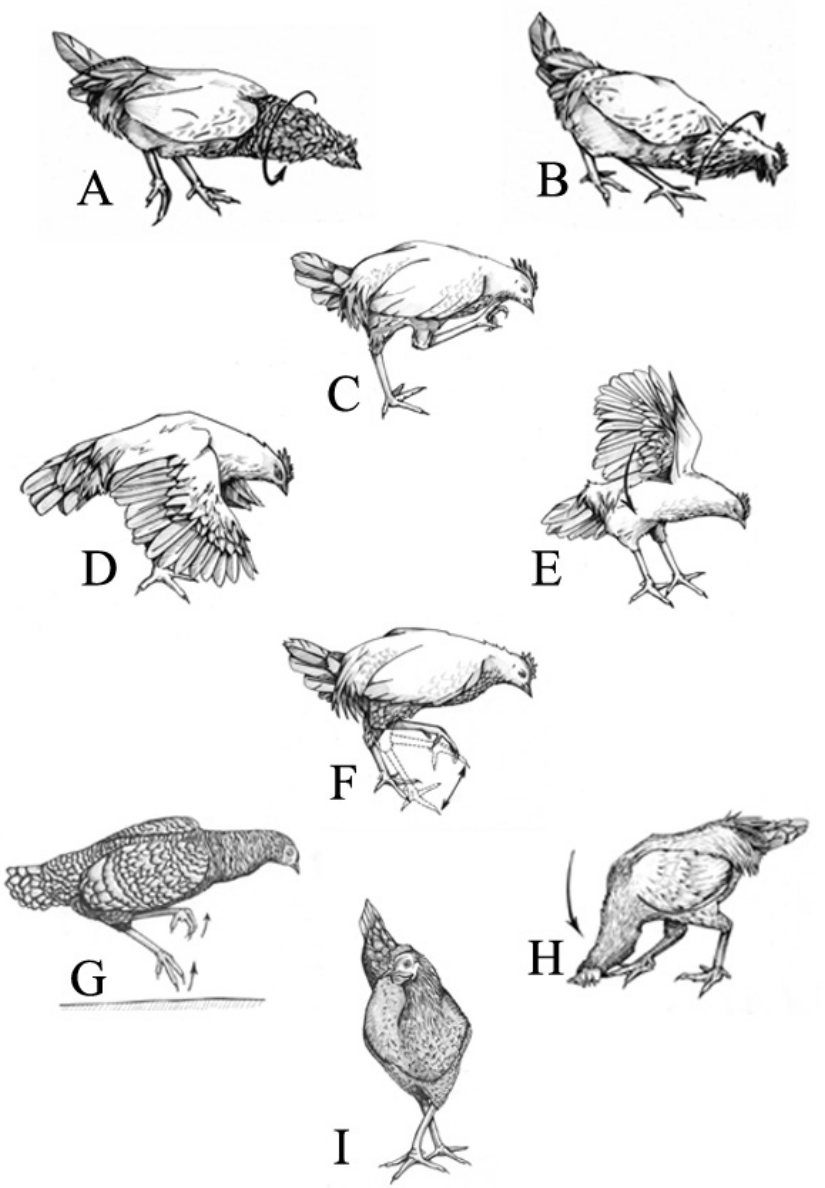
Figure 1. Representation of the aversive behaviors of the hen Gallus gallus domesticus when interacting with the yellow scorpion Tityus serrulatus . ( A , B ) shaking head; ( C ) scratch the beak/face with feet; ( D , E ) open wings; ( F ) stomp; ( G , I ) – jump; ( H ) – scratch the beak/face on substrate. Table 1. Aversive behaviors of the domestic hen Gallus gallus domesticus after being bitten by the yellow scorpion Tityus serrulatus . Category Description N Shaking head Move the head quickly and successively latero-laterally (Fig. 1, A and B) 29 Scratch the beak/face with feet Rub the beak and/or face with one foot at least once (Fig. 1 C) 14 Extend one or two wings to the side, making dorso-ventral movements with one or Open wings two wings (Fig. 1, D and E) Raising and lowering successively one foot and then the other in repeated Stomp movements (Fig. 1 F) Take both feet off of the substrate, sometimes crossing the legs and leaning the body Jump to one side (Fig. 1, G and I) Scratch the beak/face on substrate Rub the beak laterally against the substrate (Fig. 1 H)